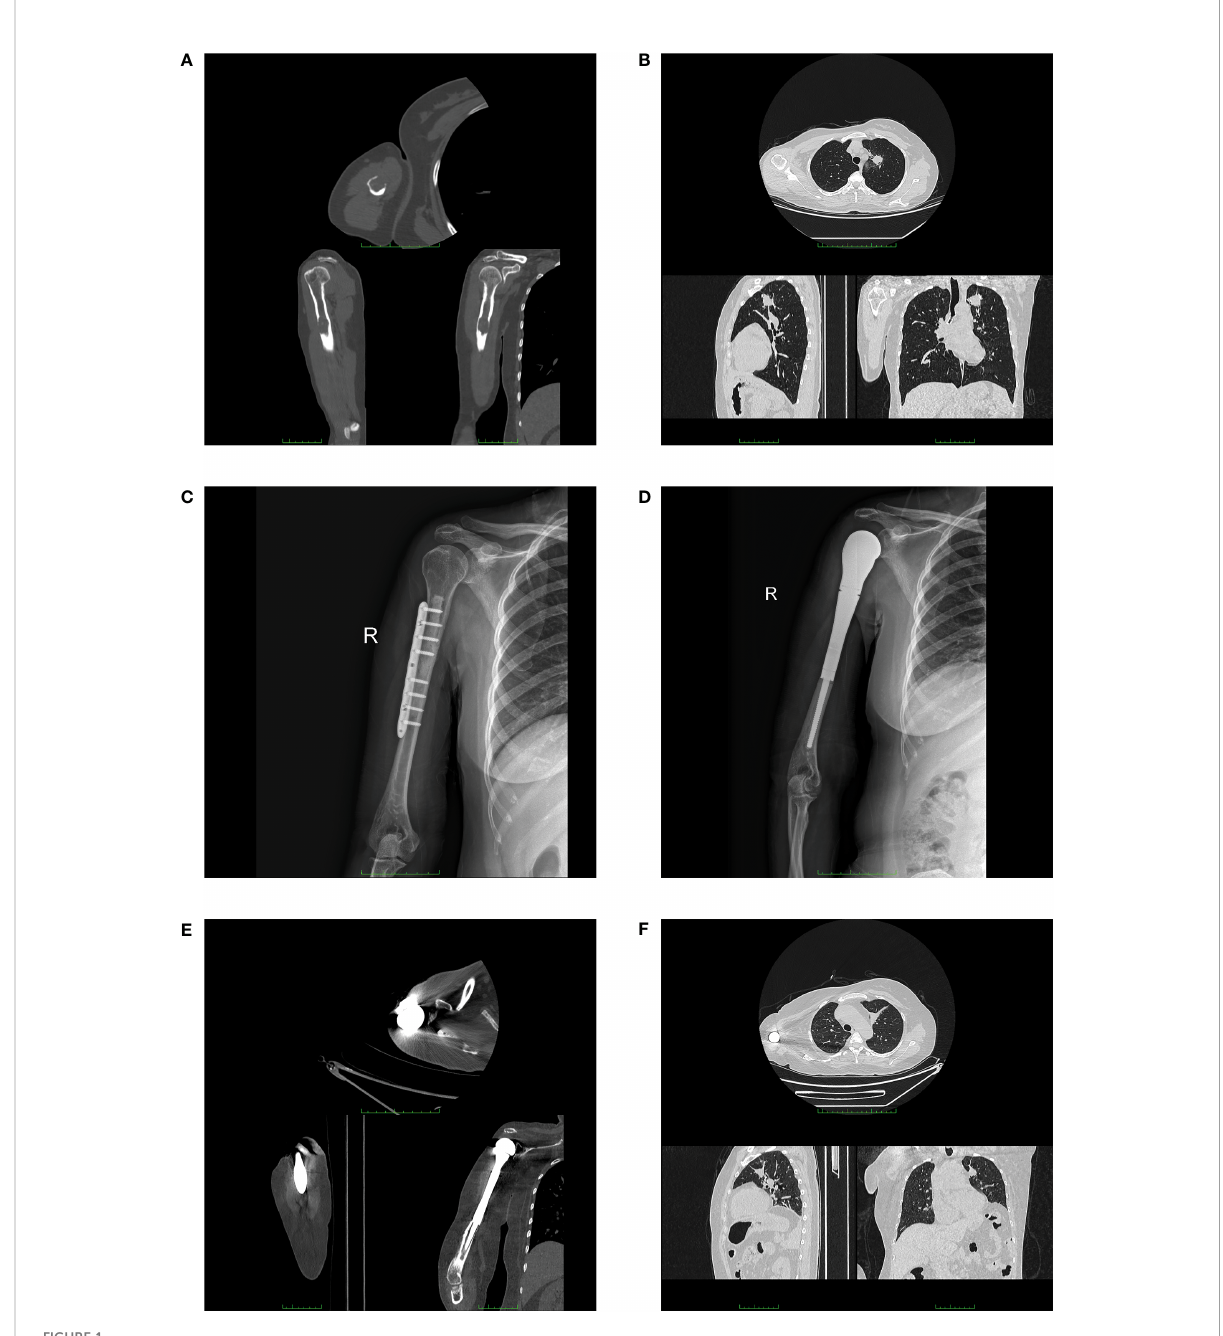
FIGURE 1 Imaging examination of the patient. Computed tomography images (upper image for axial, lower left for sagittal, and lower right for coronal, respectively) of the patient at the initial diagnosis (A, B) . (A) CT scan showed a soft tissue mass (2.4 cm × 1.8 cm) and a pathologic fracture on the right humerus of the patient. (B) Chest CT showed a pulmonary mass in the left upper lobe. X-ray images after the fi rst two surgeries (C, D) . (C) X-ray image after the surgery for plate internal fi xation on the right humerus. (D) X-ray image after the surgery for the right shoulder joint replacement. Computed tomography images (upper image for axial, lower left for sagittal, and lower right for coronal, respectively) before the surgery of shoulder disarticulation (E, F) . (E) CT scan showed the prosthesis of patient exposed out of right humerus. (F) Chest CT presented stable disease in the primary lung